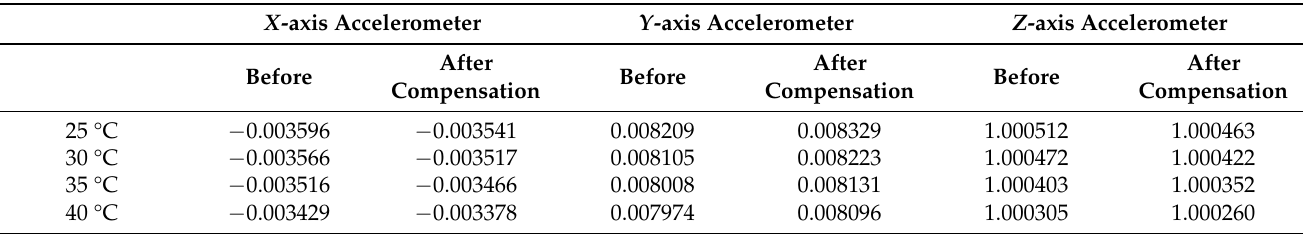
Table 3. Mean value of accelerometer at different temperature points for three-axis accelerometer. X -axis Accelerometer Y -axis Accelerometer Z -axis